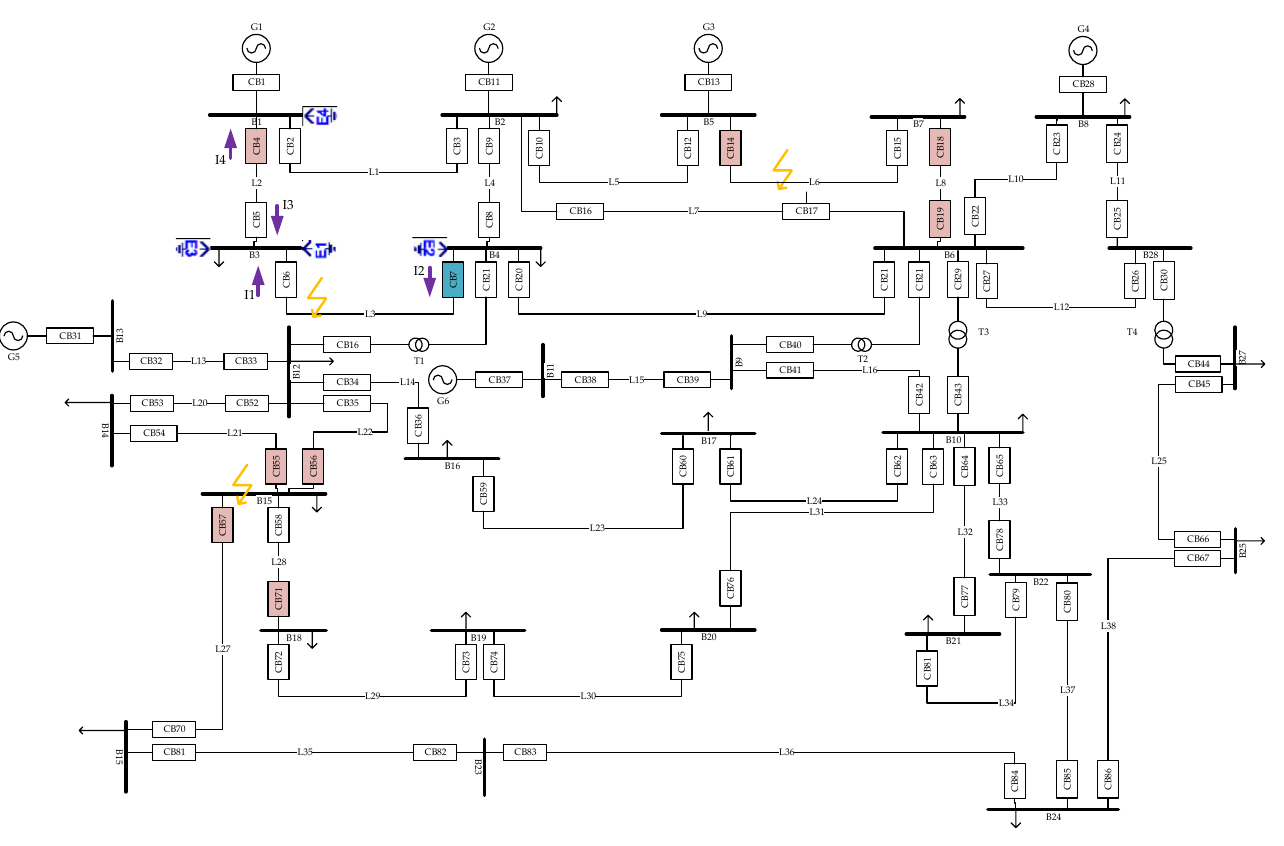
Figure 10. IEEE 30bus system partial wiring diagram.